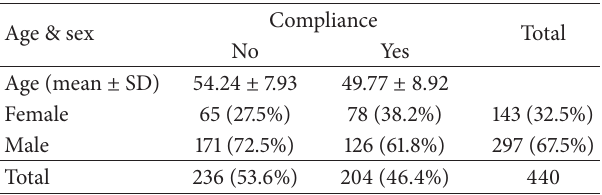
Table 1: Age & gender characteristics and compliance to antiglau- coma medication.